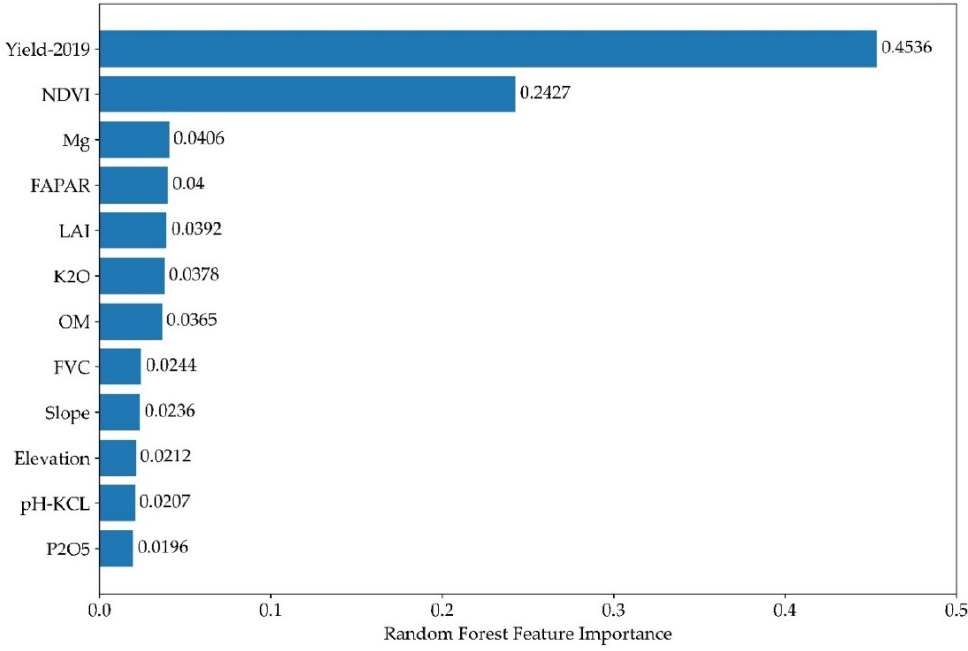
Figure 9. Result of RF feature importance.